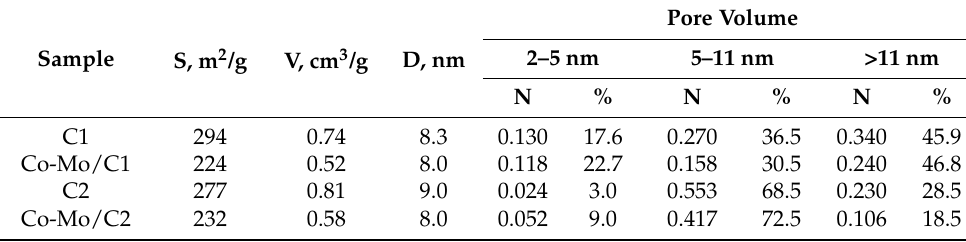
Table 1. Characteristics of aluminum oxides and catalysts.